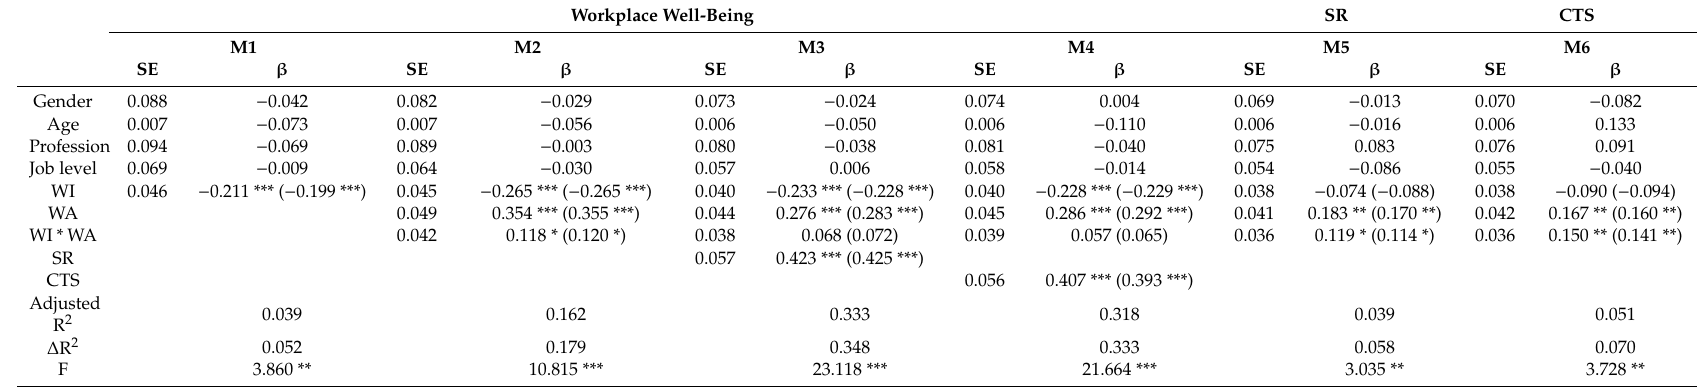
Table 3. Results of regression